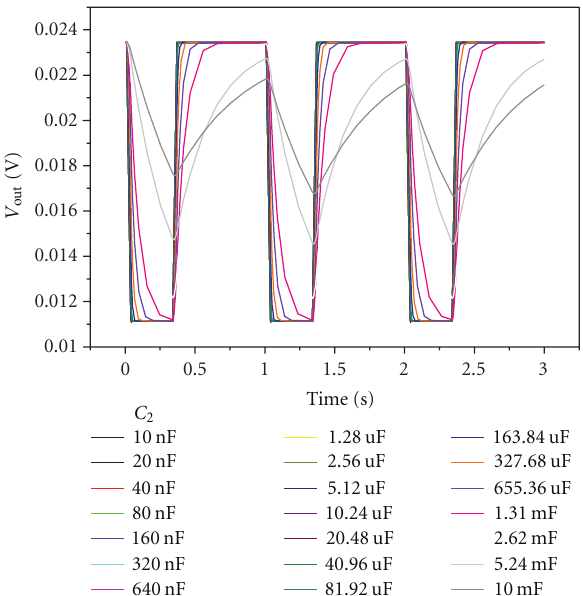
Figure 21: Output data for the pulse parameter for a change of the capacitance of C 2 (10 (nF) ∼ 10 (mF)).